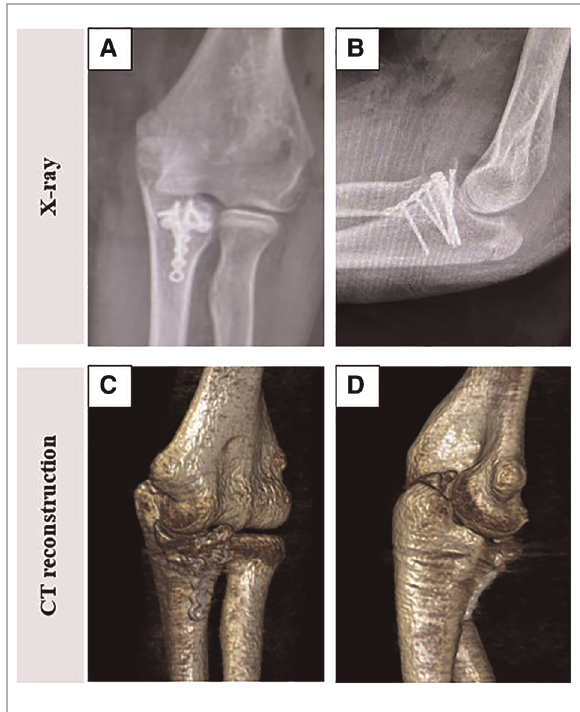
FIGURE 3 Postoperative imaging showed Normal recovery of the left elbow dislocation. ( A,B ) Radiographs show that the internal fi xation device is in good position; ( C,D ) Three-dimensional computed tomography showed no arthritic or graft absorption of the